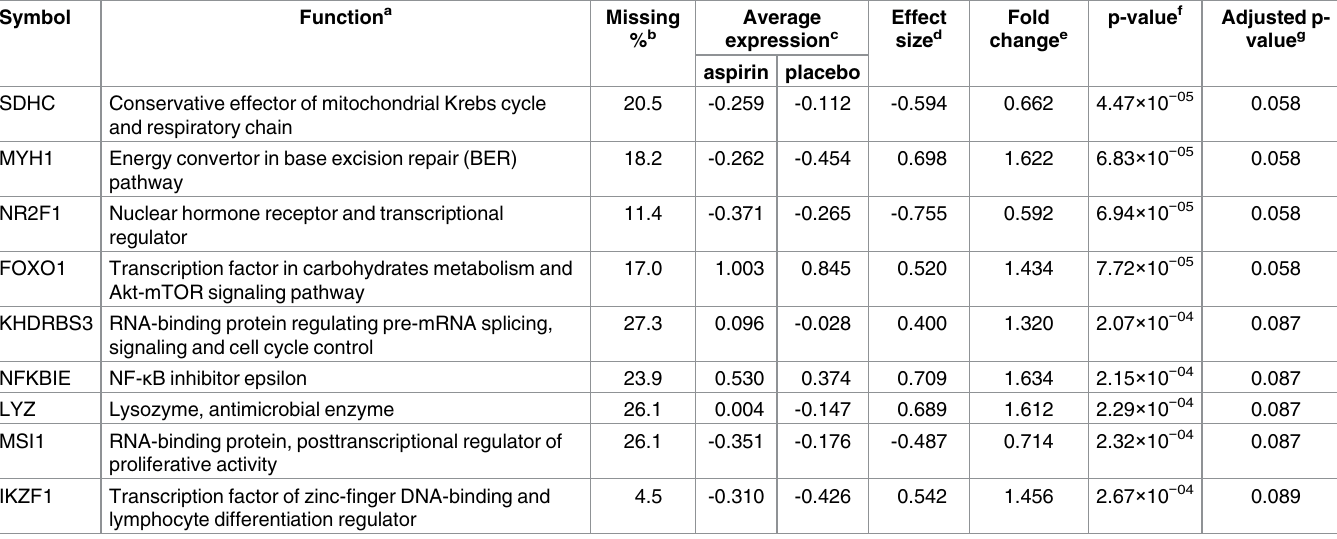
largest increases: the expression level was 63% higher on aspirin than placebo. Because the study was conducted as a randomized crossover study, each participant served as their own Table 2. Proteins that differed significantly between aspirin and placebo periods with false discovery rate (FDR) < 0.10.